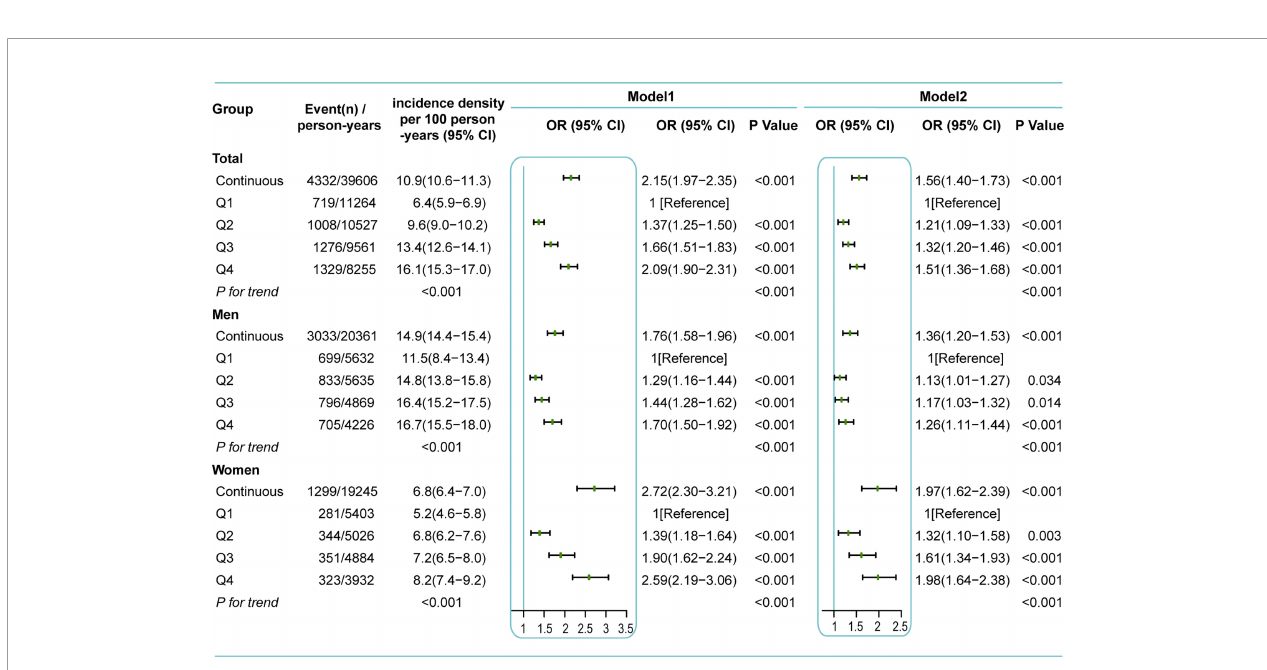
FIGURE 4 | Incidence density and GEE analysis for incident NAFLD based on RBC count during follow-up. Q1, the lowest quartile of RBC count (<4.83×10 12 cells/L for men, <4.33×10 12 cells/L for women); Q2, the second quartile of RBC count (4.83-5.08×10 12 cells/L for men, 4.33-4.52×10 12 cells/L for women); Q3, the third quartile of RBC count (5.09-5.32×10 12 cells/L for men, 4.53-4.74×10 12 cells/L for women); Q4, the highest quartile of RBC count (>5.32×10 12 cells/L for men, >4.74×10 12 cells/L for women). Model 1 was adjusted for age, follow-up time. Model 2 was adjusted for age, BMI, SBP, GLU, TG, HDL-C, LDL-C, diet, smoking, exercise, follow-up time, and residual errors of regressing Hb on RBC. Sex was also adjusted in all models of the total group.